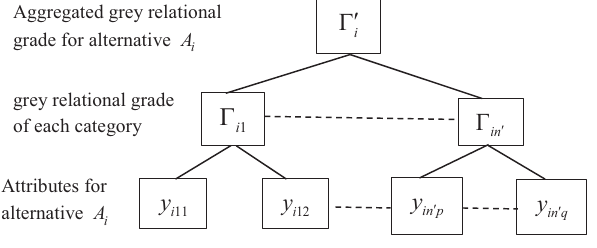
Figure 3. The computational structure of a